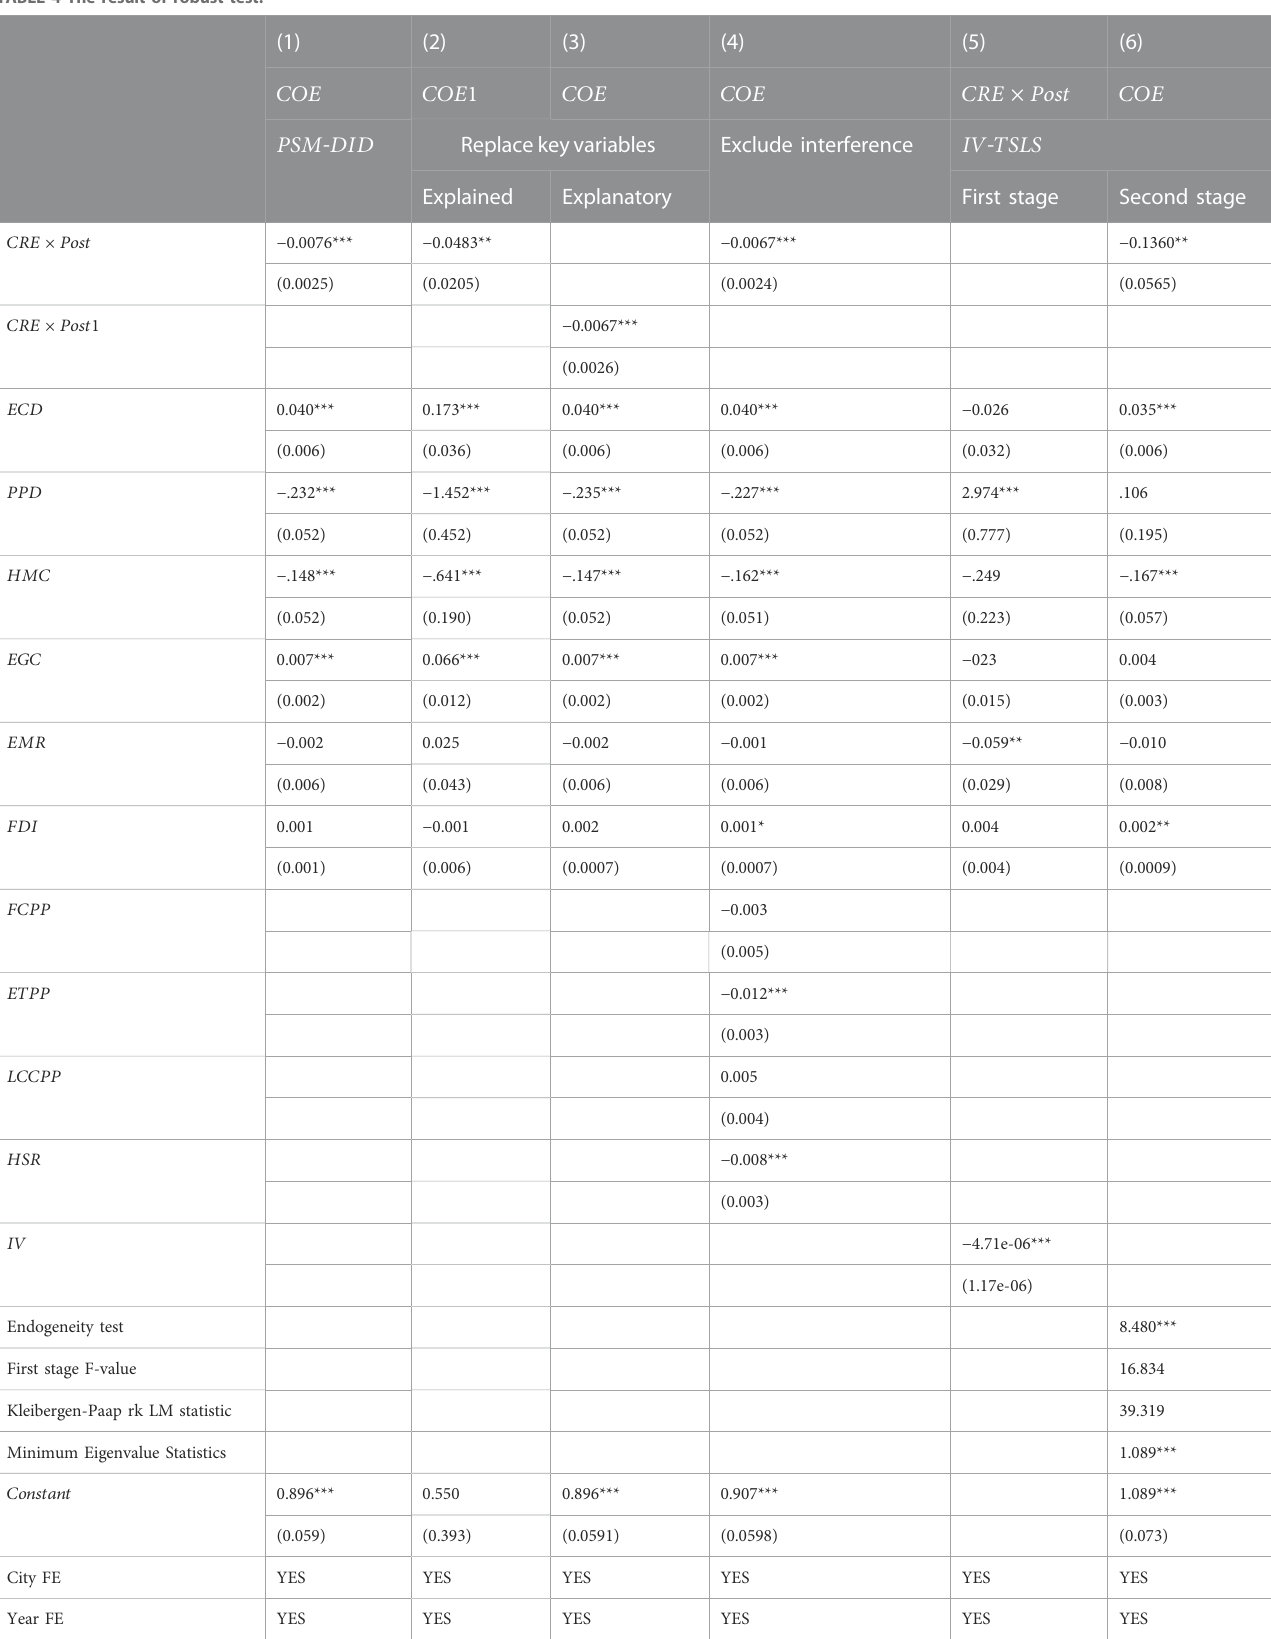
TABLE 4 The result of robust